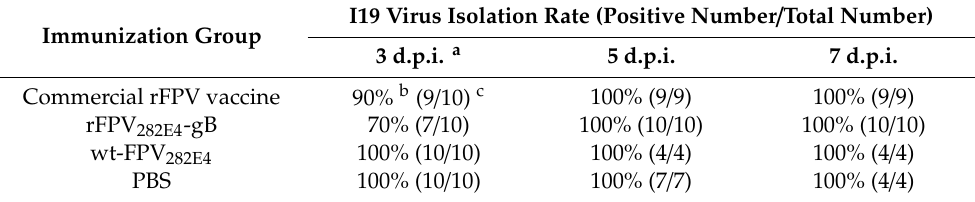
Table 5. Virus shedding in vaccinated chickens challenged with ILTV I19